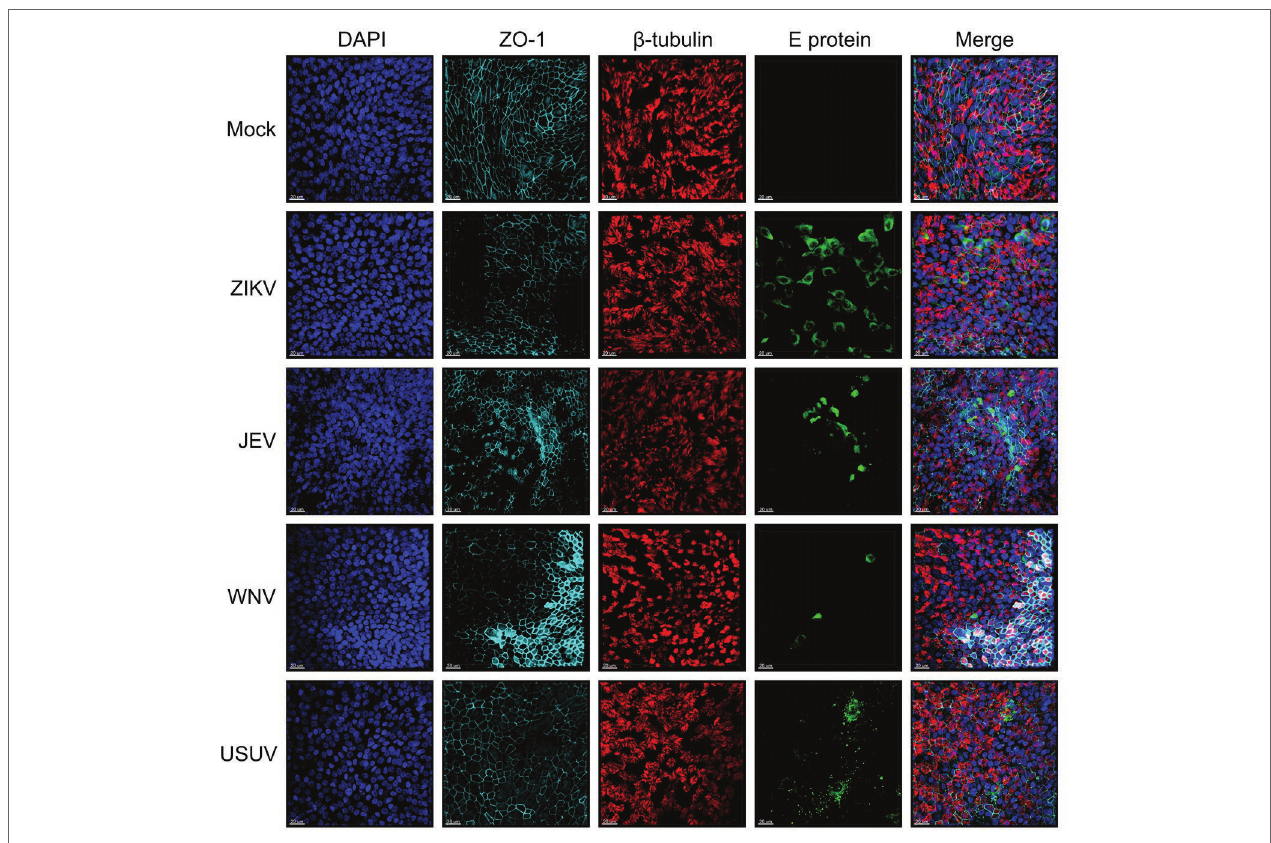
FIGURE 1 | Susceptibility of human NECs to flaviviruses. Confocal microscopy analysis 72 h p.i. with mock, ZIKV, JEV, WNV, and USUV at a MOI of 1 TCID 50 /cell. Blue: DAPI, light blue: ZO-1, red: β -tubulin, green: flavivirus E protein. The micrographs presented are representative of data generated from six independent donors. Bar 20